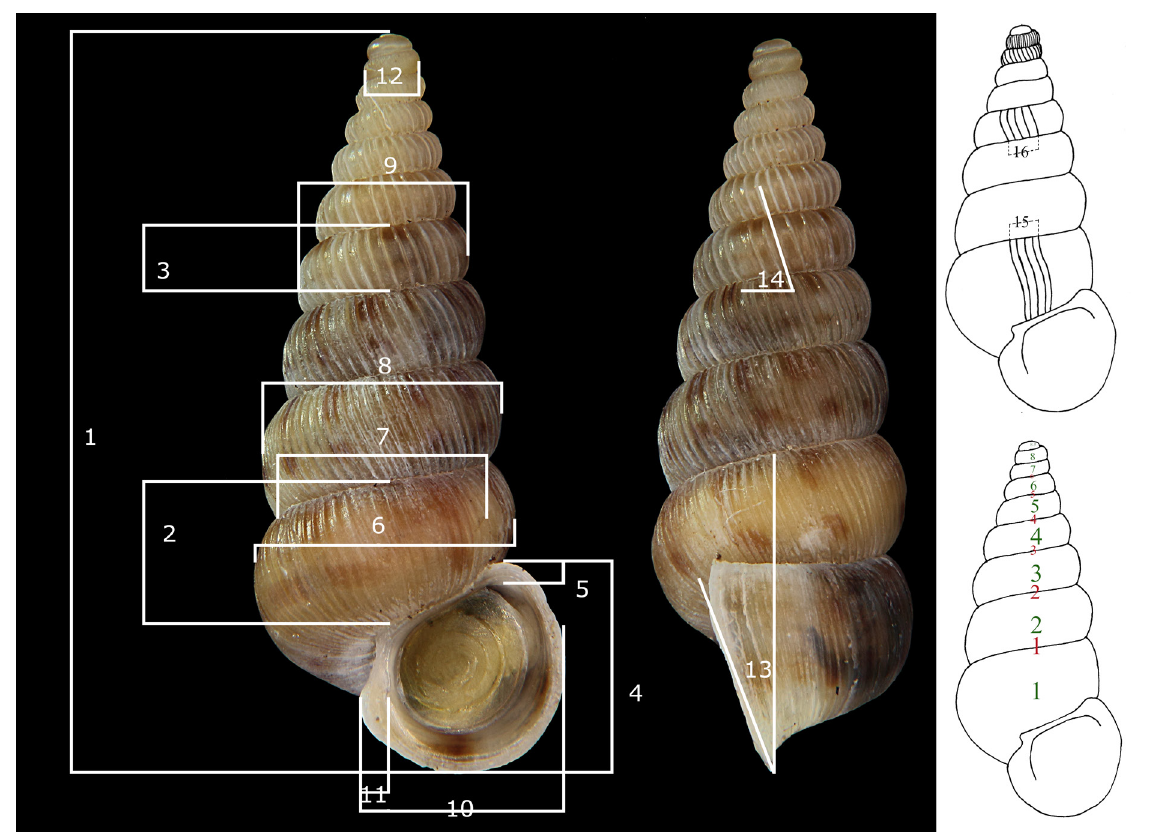
Fig. 2. Measurements taken on the shell of Clessiniella Zallot et al . 2015. 1 = height (H); 2 = height of the 1 st whorl; 3 = height of the 4 th whorl; 4 = height of the aperture (Ha); 5 = height of the external lobe; 6 = width of the 1 st whorl (W); 7 = width of the 1 st suture; 8 = width of the 2 nd whorl; 9 = width of the 4 th whorl; 10 = width of the aperture (Wa); 11 = maximum width of the lip on the columellar side; 12 = width of the basal whorl of the protoconch; 13 = inclination of the aperture; 14 = inclination of the ribs; 15 = distance between the 5 central ribs of the body whorl; 16 = distance between the 5 central ribs of the 4 th whorl. The figure in the lower right corner shows how the whorls (green) and sutures (red) are